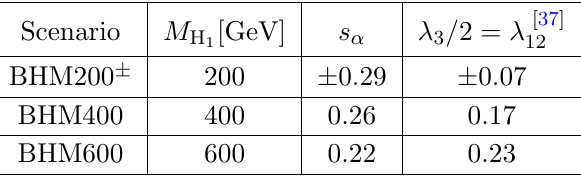
Table 3 . HSESM input parameters in the considered HSESM scenarios. The light Higgs boson has mass M H = 125 : 1 GeV. 2